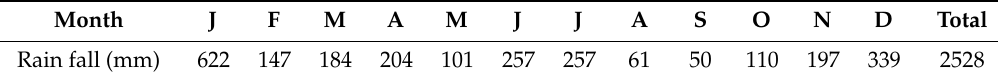
Table 6. Monthly mean relative humidity (%). Table 7. Monthly amount of rainfall.